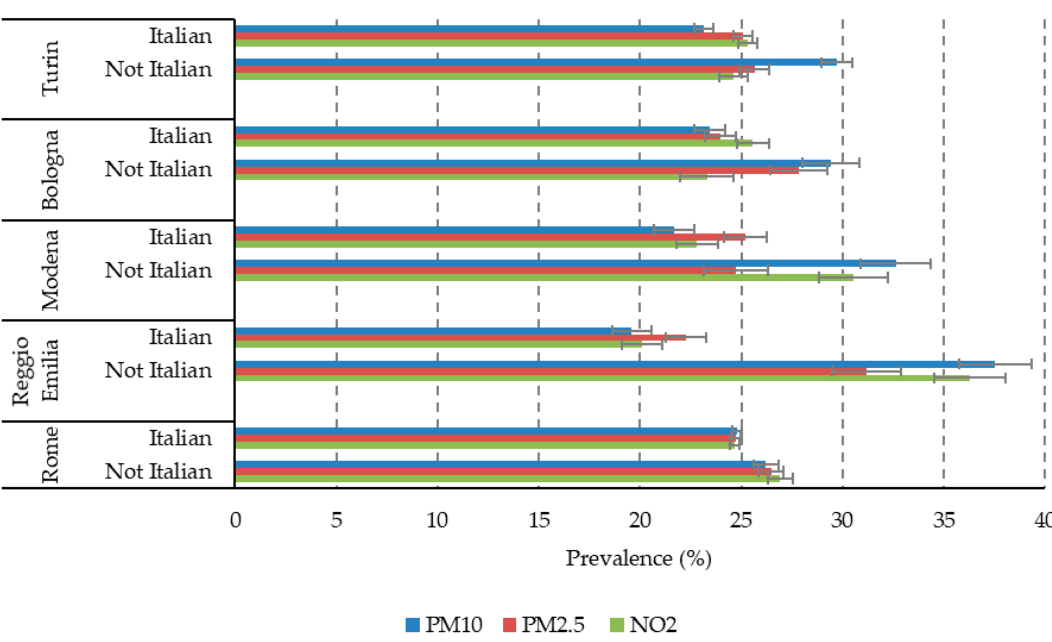
Figure 2. Prevalence of high air pollution exposure (>75th percentile) by city and maternal occupation.